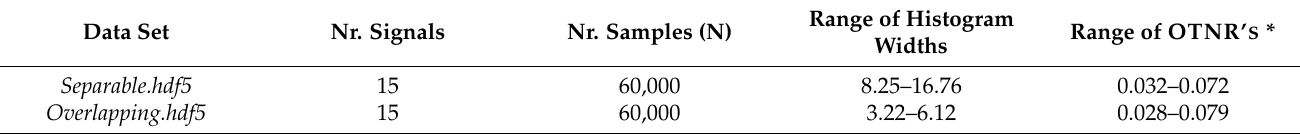
Table 1. Overview of available signals and signal